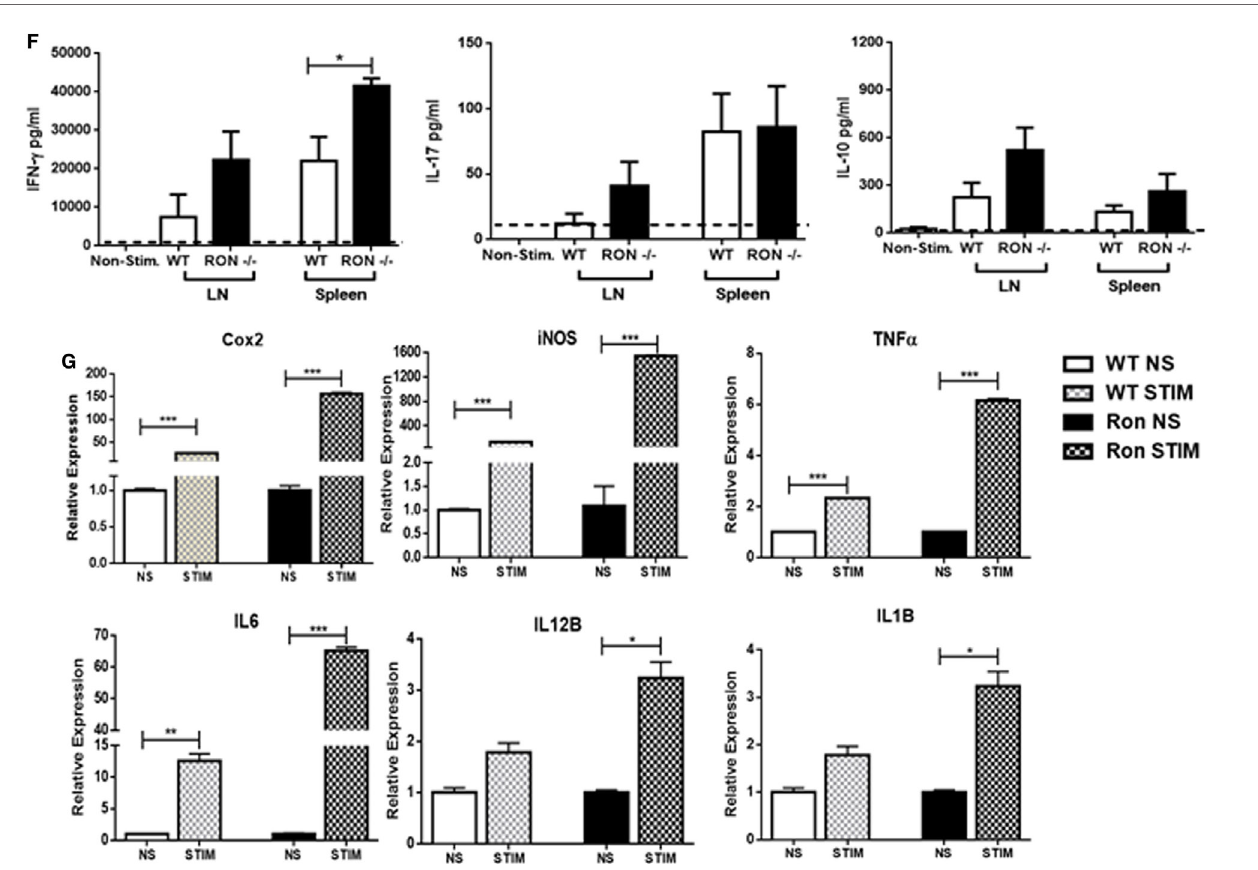
FigUre 3 | Ron plays a protective role in the progression of experimental autoimmune encephalomyelitis. (a,B) Wild-type (WT) and Ron − / − mice were immunized with myelin oligodendrocyte glycoprotein (MOG) at 8–10 weeks of age and disease progression was monitored daily for 27 days ( n = 14 mice/genotype). (c) Expression of pro-inflammatory genes in the central nervous system (CNS) of WT and Ron − / − mice 14 days following immunization with MOG ( n = 6 mice/genotype). (D,e) Total CNS immune cells were isolated from WT and Ron − / − mice 14 days following immunization and the presence of infiltrating CD45 + F480 + CD206 + cells were assessed by flow cytometry ( n = 6 mice/genotype). (F,g) Inguinal and axillary lymph nodes and spleens were isolated from WT and Ron − / − mice at day 14 following immunization and restimulated with MOG for 72 h. Levels of IFN- γ , IL-17, and IL-10 in the supernatant was determined by ELISA and expression of pro-inflammatory cytokines was assessed by qPCR ( n = 6 mice/genotype) (* P < 0.05, ** P < 0.01, *** P <